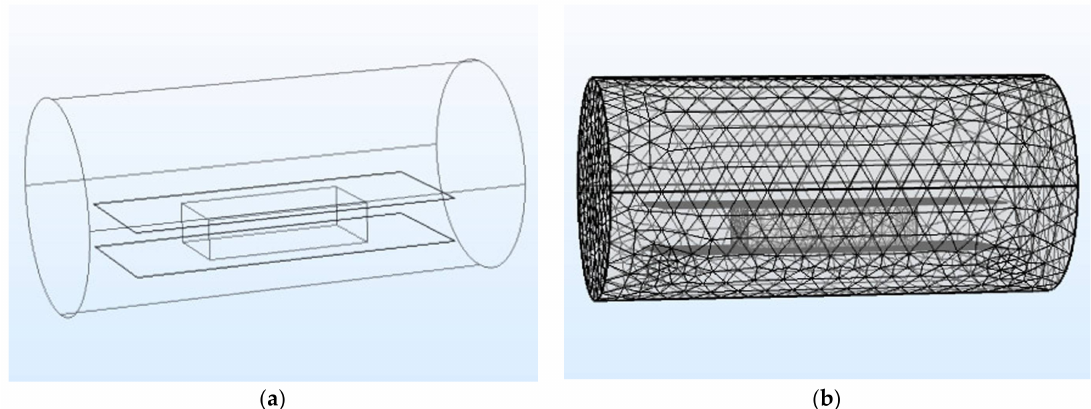
Figure 1. Model development. ( a ) Geometric model; ( b ) Mesh